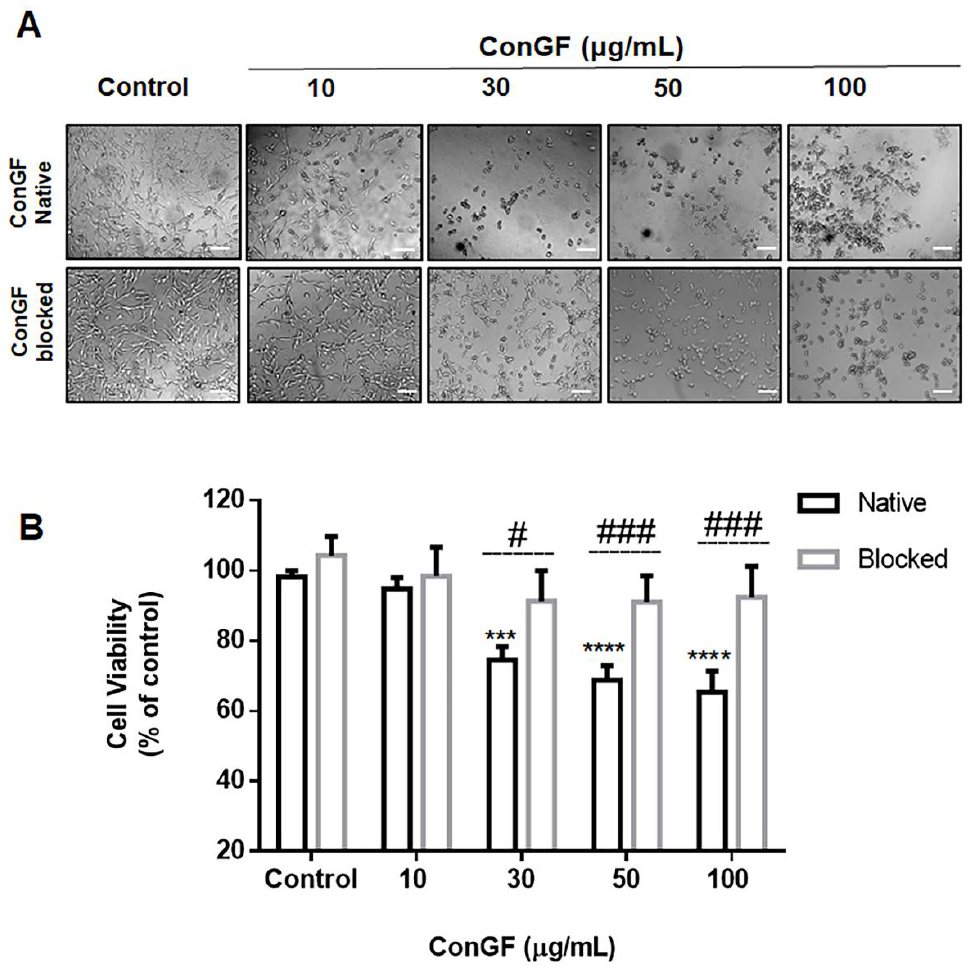
Figure 2. Effect of ConGF on C6 glioma cell viability is dependent of CRD. C6 glioma cells were treated with vehicle (HEPES; control), native ConGF (10, 30, 50, or 100 µ g/mL), or ConGF blocked with α -methyl- D -mannoside for 24 h. ( A ) Representative images of cell morphology captured by inverted NIKON eclipse T2000-U microscope (10 × magnification) treated with native and blocked lectin. ( B ) Cell viability assessed by the MTT assay. Values are represented as mean ± SEM of three independent experiments performed in triplicate. *** p < 0.001 and **** p < 0.0001 when compared to the vehicle-treated group (control) and # p < 0.05 and ### p < 0.001 when compared to the native lectin-treated